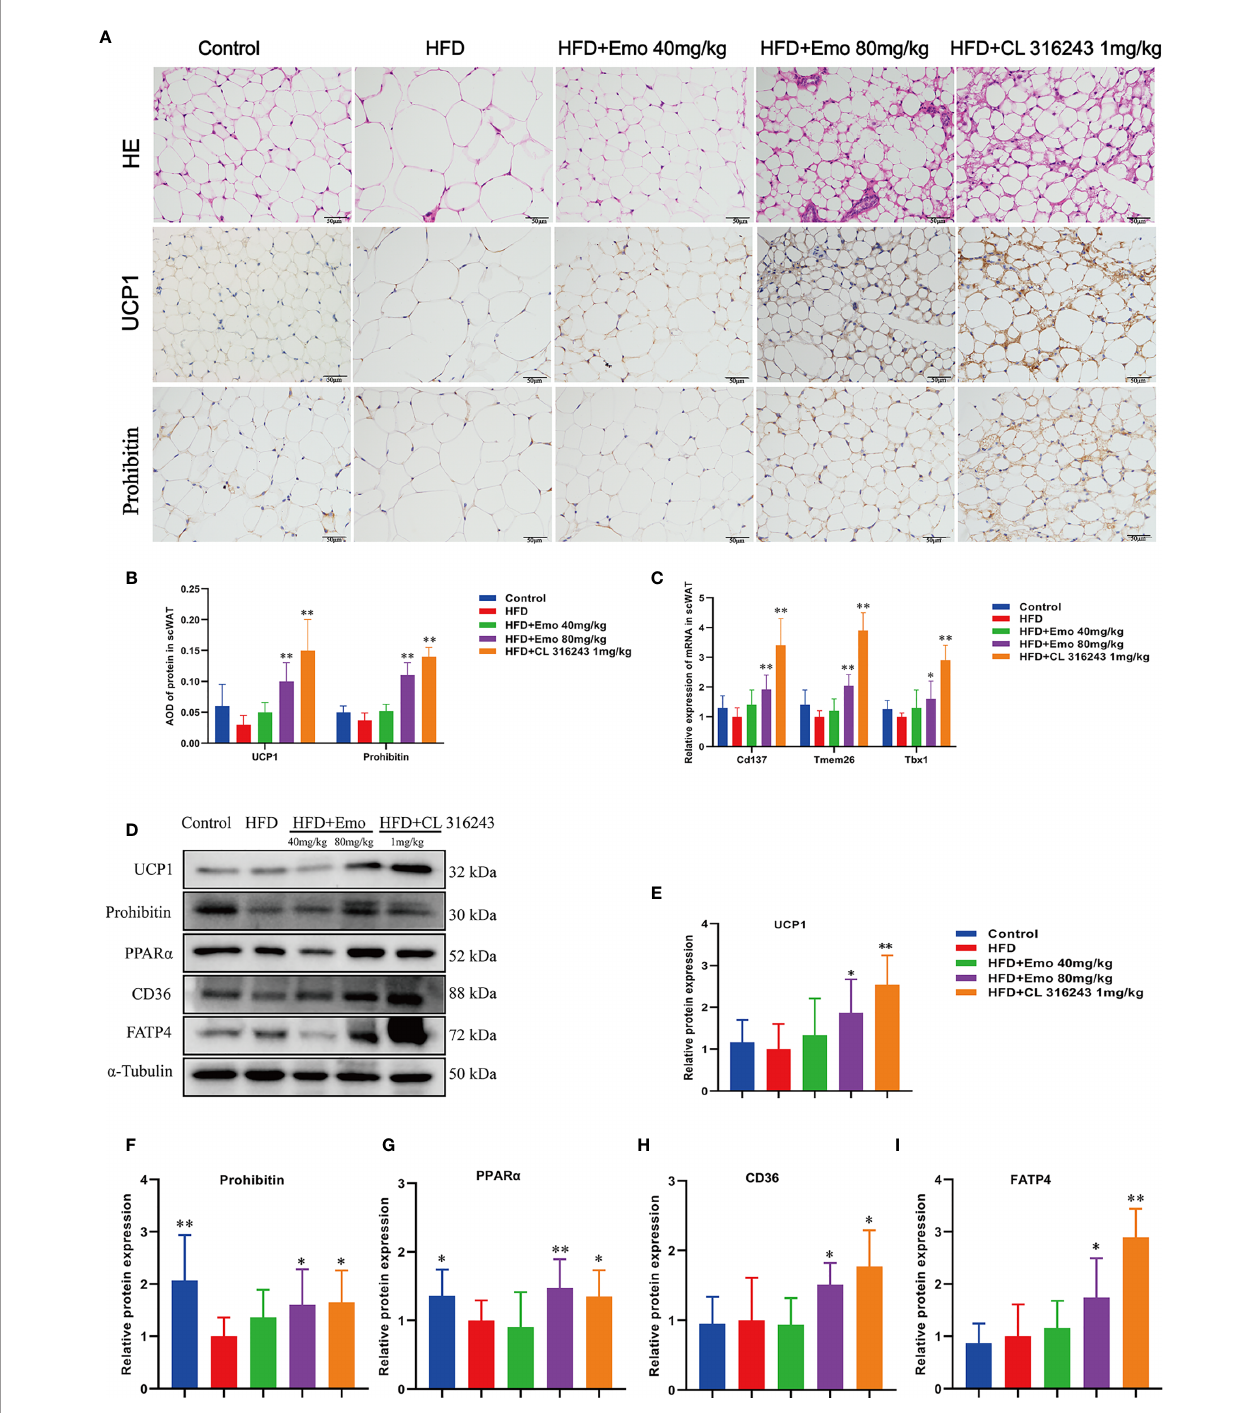
FIGURE 3 | Effects of emodin on the morphology and function of scWAT in HFD mice. (A) H&E and immunohistochemical staining of scWAT. (B) Relative expression of UCP1 and Prohibitin protein in scWAT. (C) Relative expression of Cd137 , Tmem26 and Tbx1 mRNA in scWAT. (D) Protein expression of UCP1, prohibitin, PPAR a , CD36 and FATP4 in scWAT using western blotting. (E) Protein expression of UCP1. (F) Protein expression of prohibitin. (G) Protein expression of PPAR a . (H) Protein expression of CD36. (I) Protein expression of FATP4. HFD, high fat diet; Emo, emodin. Data are expressed as mean ± SE. * P < 0.05, ** P < 0.01 vs. HFD